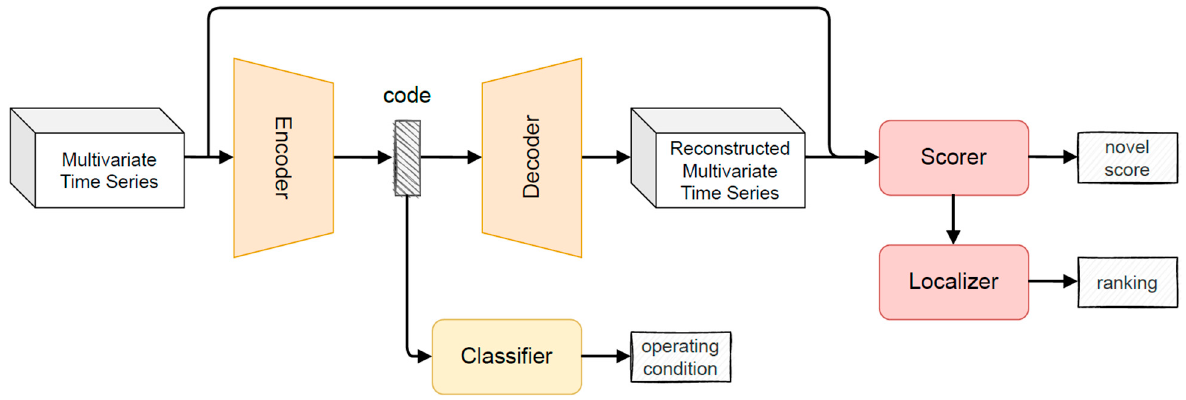
Figure 1. Autoencoder Architecture Template.